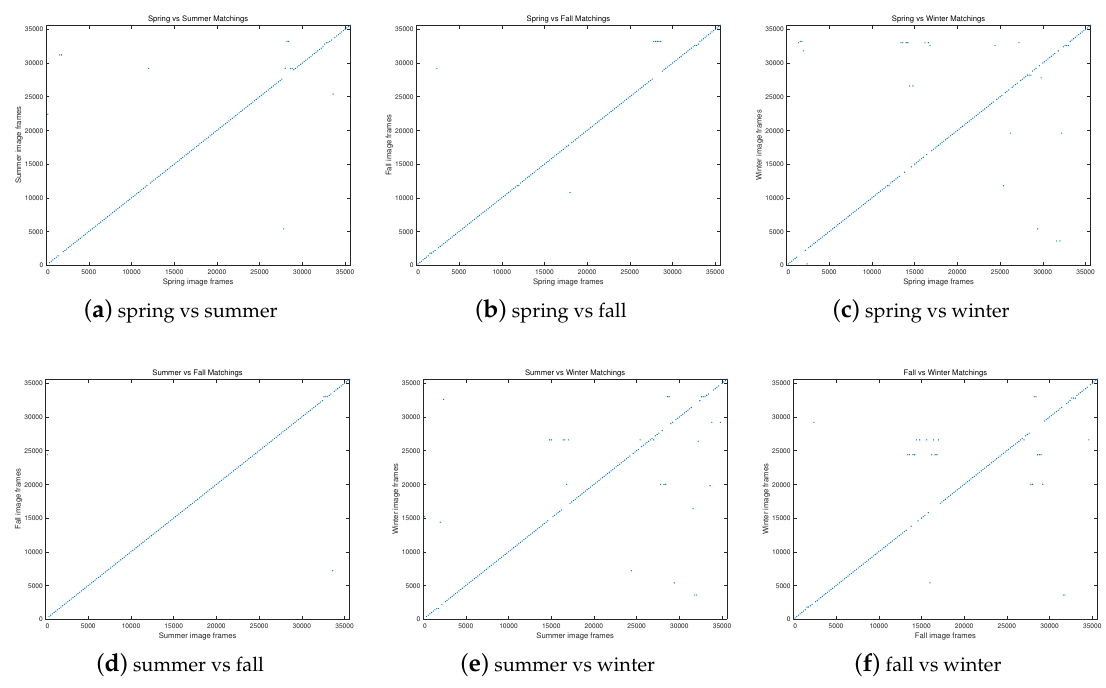
Figure 8. Matching results under different season couples at 100% recall situation. The expected results (true matching) are along the